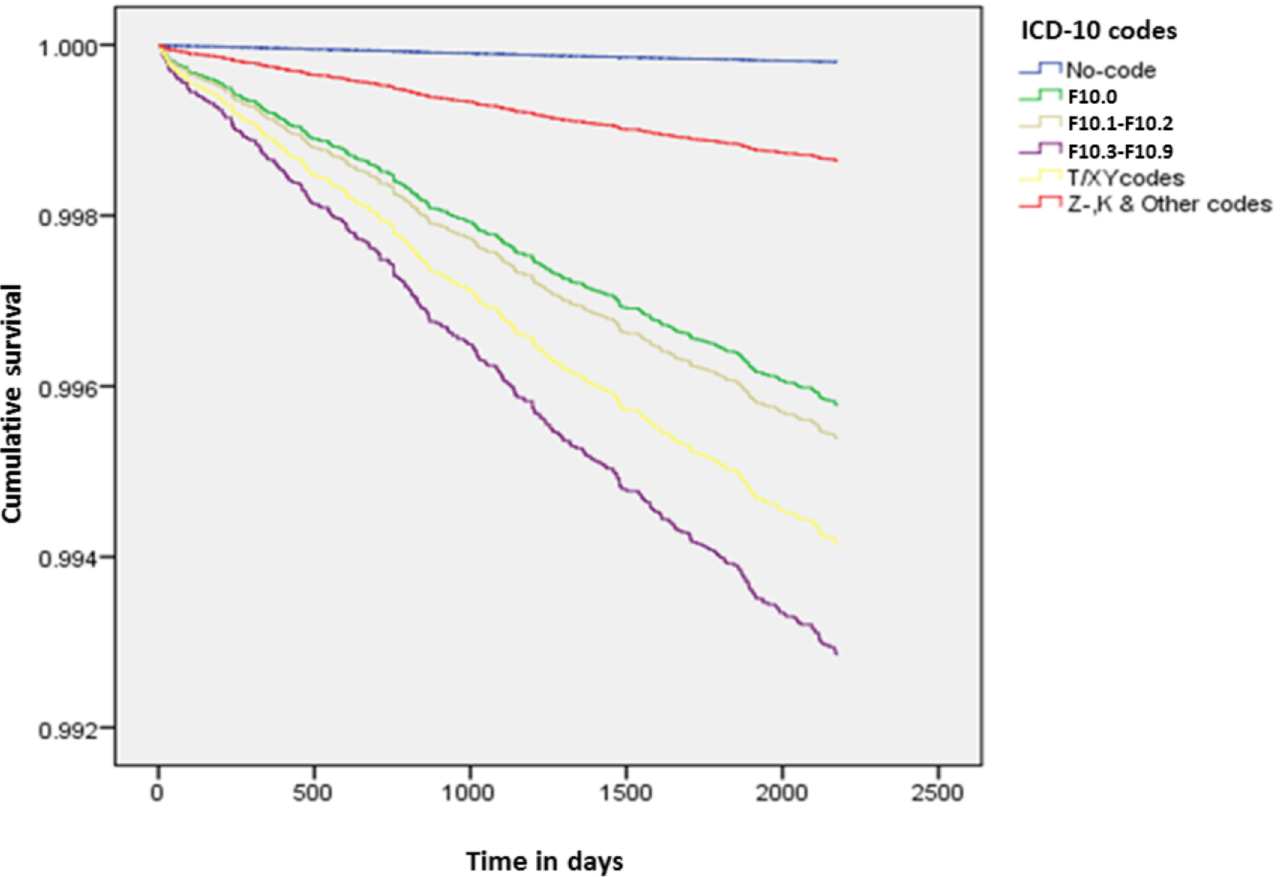
Fig 3. Cumulative survival plot for diagnostic categories of alcohol-related admissions: